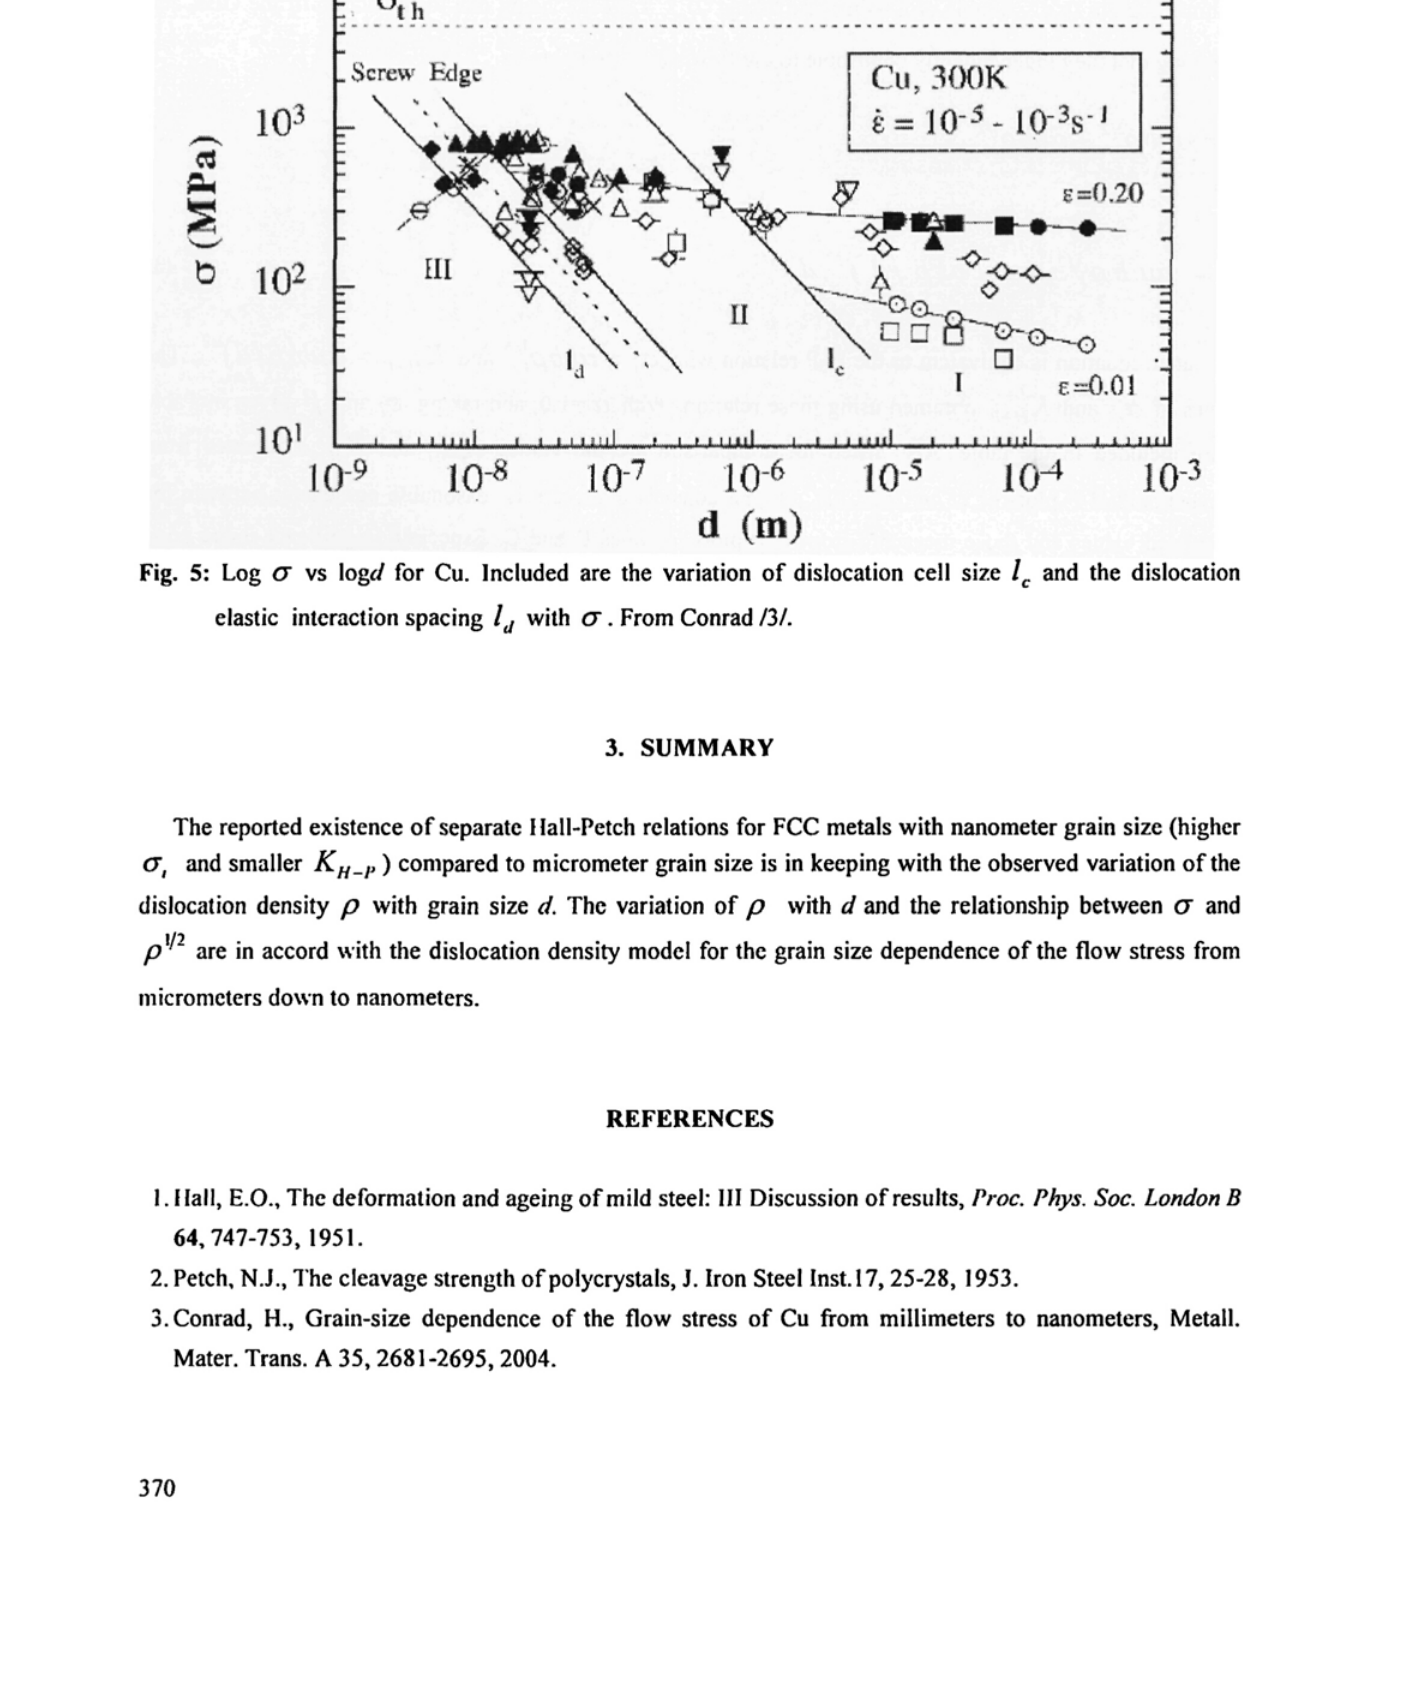
and the dislocation c